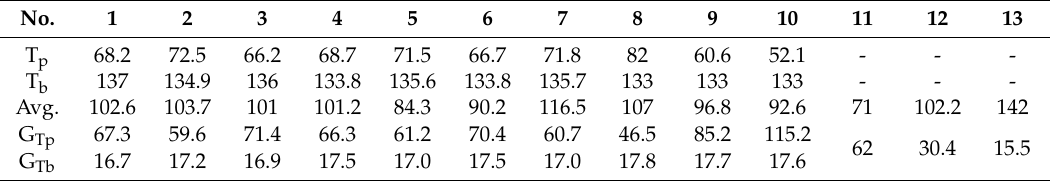
Table 3. Heat input rate (KJ / m) and the thermal gradient of weld pool (K × mm − 1 ) with different parameters.